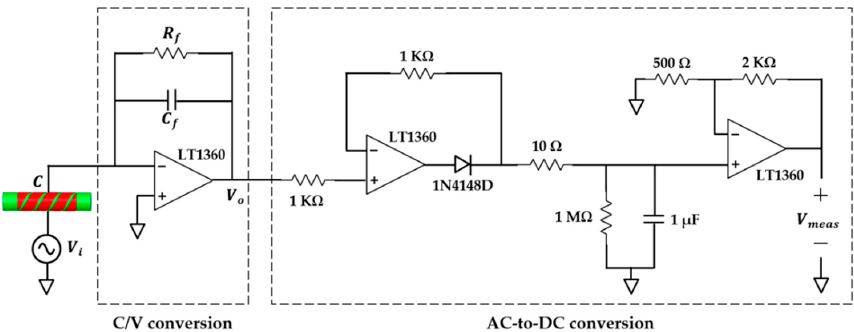
Figure 9. Schematic diagram of the capacitance interface circuit.